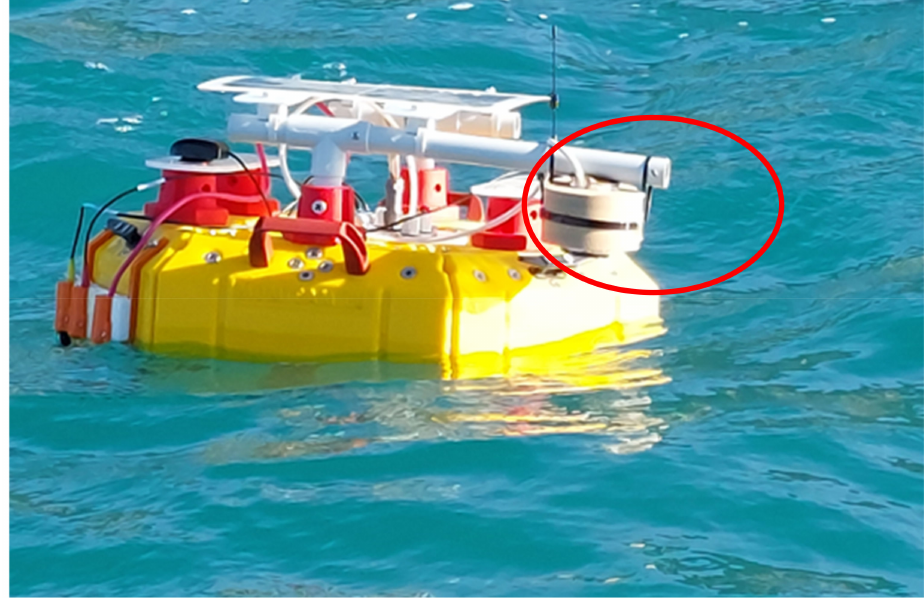
Figure 10. Impermeability test of the microplastic sensor (red circle) mounted onboard a